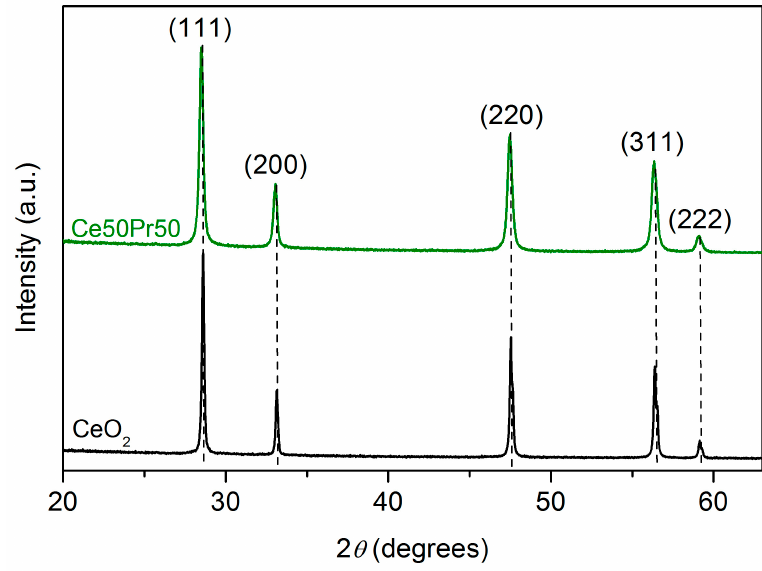
Figure 1. XRD di ff ractograms of the Ce50Pr50 catalyst and of pure Figure 1. XRD diffractograms of the Ce50Pr50 catalyst and of pure ceria.